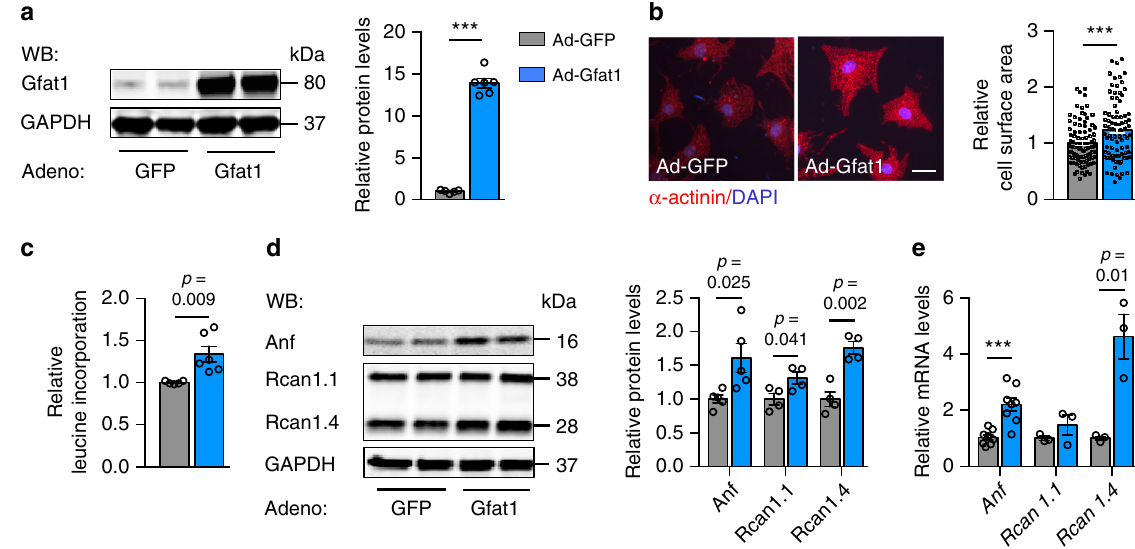
Fig. 2 Overexpression of Gfat1 induces hypertrophic growth in cardiomyocytes. a NRVMs were infected with adenovirus expressing either control GFP (Ad-GFP) or Gfat1 (Ad-Gfat1). Gfat1 protein level was examined by immunoblotting and quanti fi ed. GAPDH was used as a loading control. N = 5 for Ad- GFP; n = 6 for Ad-Gfat1. b Representative images of NRVMs stained for α -actinin (red) and the nucleus (DAPI, blue) are shown. Scale: 20 μ m. Bar graph depicts relative fold changes in cardiomyocyte surface area normalized to the cells infected by Ad-GFP. N = 91 cells for Ad-GFP; n = 86 cells for Ad-Gfat1. At least three independent experiments were conducted with two to three samples/group/experiment. c Radioactive leucine was included in culture media after Gfat1 overexpression. Leucine incorporation was quanti fi ed as indication of protein synthesis. N = 5 for Ad-GFP; n = 6 for Ad-Gfat1. d Overexpression of Gfat1 in NRVMs led to upregulation of hypertrophic marker genes (Anf, Rcan1.4) at the protein levels. N = 5 for Anf; n = 4 for Rcan1. e The hypertrophic marker gene expression was augmented by Gfat1 overexpression at the mRNA levels, as examined by real-time PCR. N = 8 for Anf ; n = 3 for Rcan1 . Data are shown as mean ± SEM. Student ’ s t test (two-tailed) was conducted to calculate signi fi cance. *** p < 0.001. Source data are provided as a Source Data fi